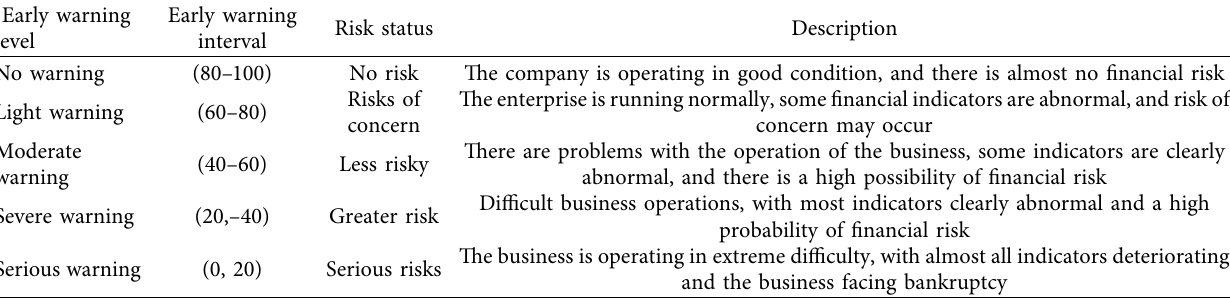
Figure 7: Histogram of the results of the revenue allocation risk indicator Table 3: Classification of the company’s financial risk warning level.